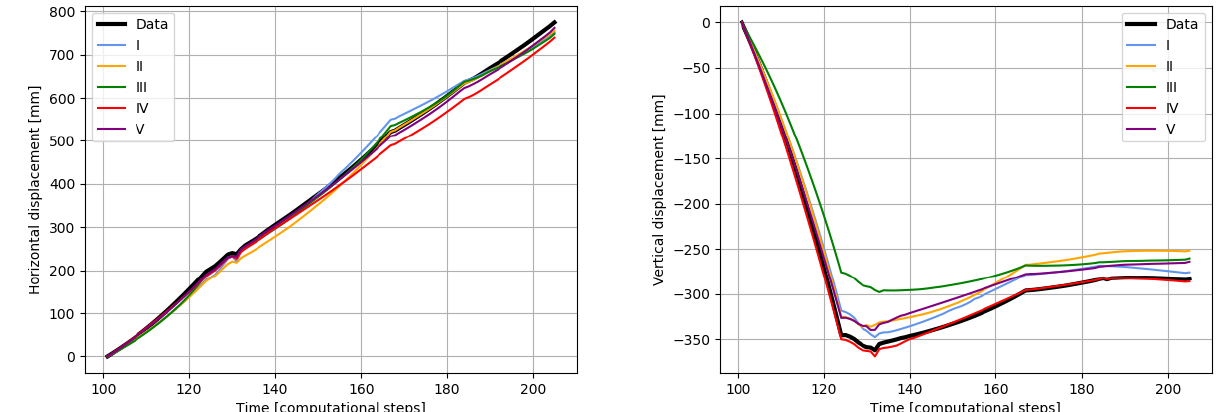
Figure 9: Results of horizontal (left) and vertical (right) displacement in benchmark